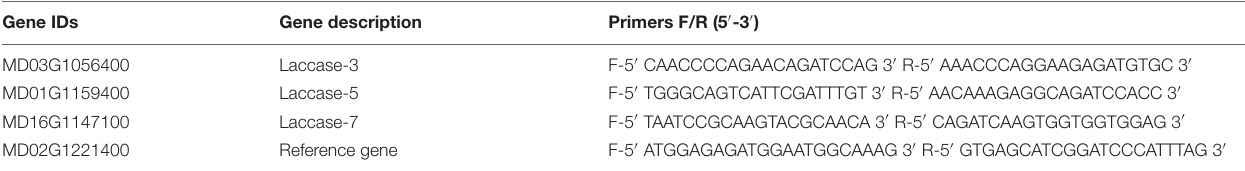
TABLE 1 | Primer sequences of laccase and reference genes used for qRT-PCR analysis to study their expression patterns in apple roots in response to Pythium ultimum infection. Gene